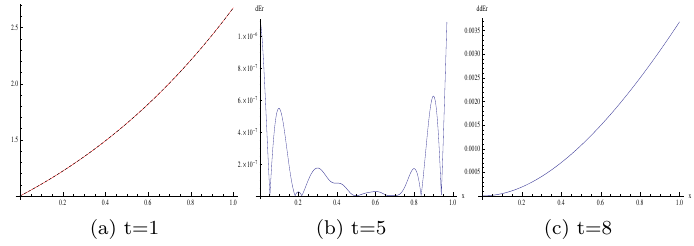
Figure 1. Left side curves are the images of approximate solution u 33 ( x ) (dotted line)and exact solution u ( x ) (solid line)for Example 1; Middle side curve is the absolute error between u (cid:48) ( x ) and u (cid:48) ( x ) for Example 1; Right side curve is the absolute error 33 between u (cid:48)(cid:48) ( x ) and u (cid:48)(cid:48) ( x ) for Example 1 33